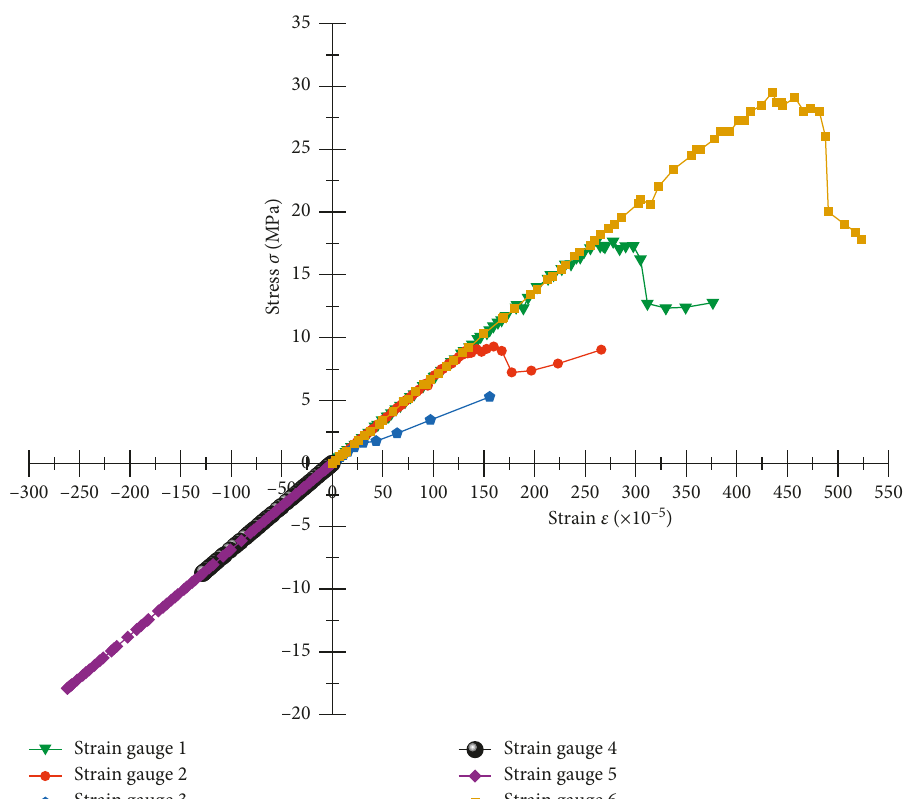
Figure 11: Relationship between the stress and the